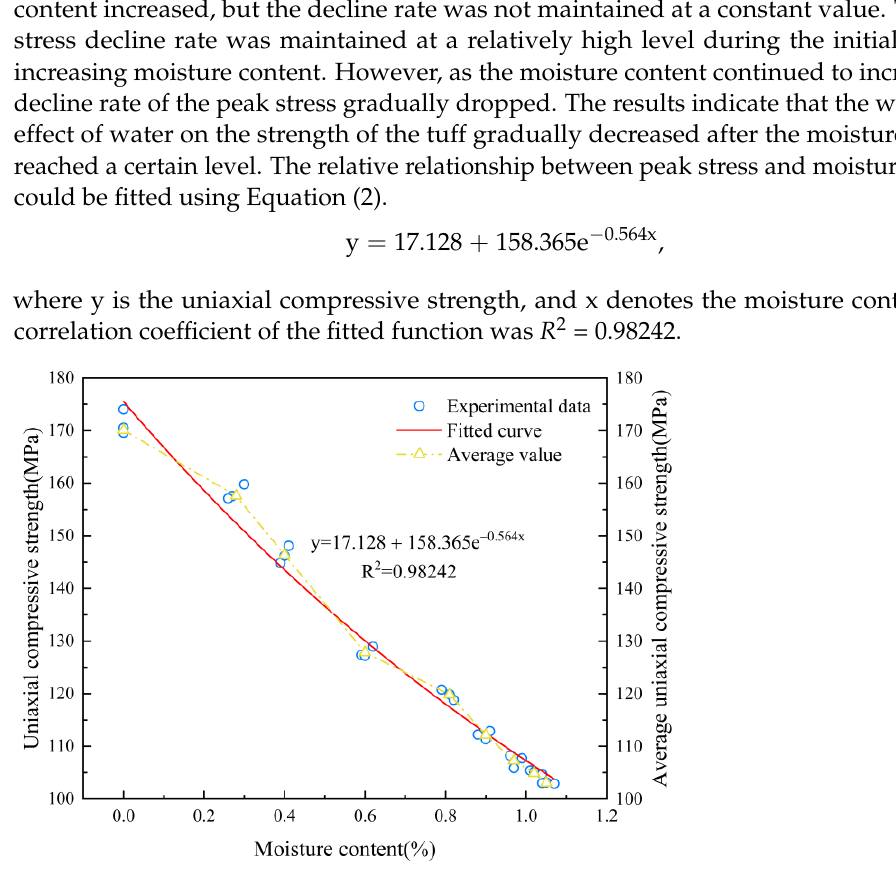
Figure 5. Relationship between uniaxial compressive strength and moisture content.